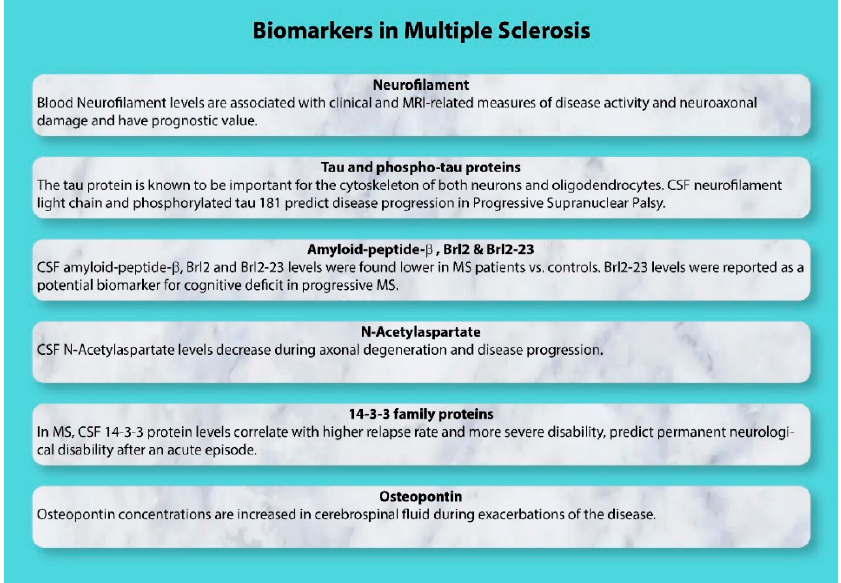
Figure 2. Biomarkers in Multiple Sclerosis. Biomarkers of neurodegeneration and inflammation are indicated. Neurodegeneration biomarkers include Neurofilament, Tau and phosphotau protein, amyloid-peptide- β , Brl2 and Brl2-23, N-Acetylaspartate, and 14-3-3 family proteins, whereas Osteopontin is an inflammation